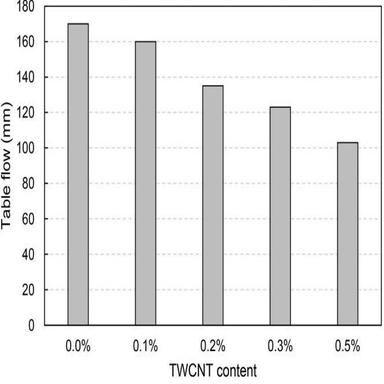
Table flow level of the samples.